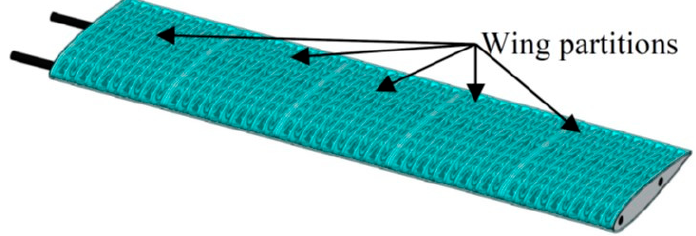
Figure 1. The proposed span morphing wing assembly.